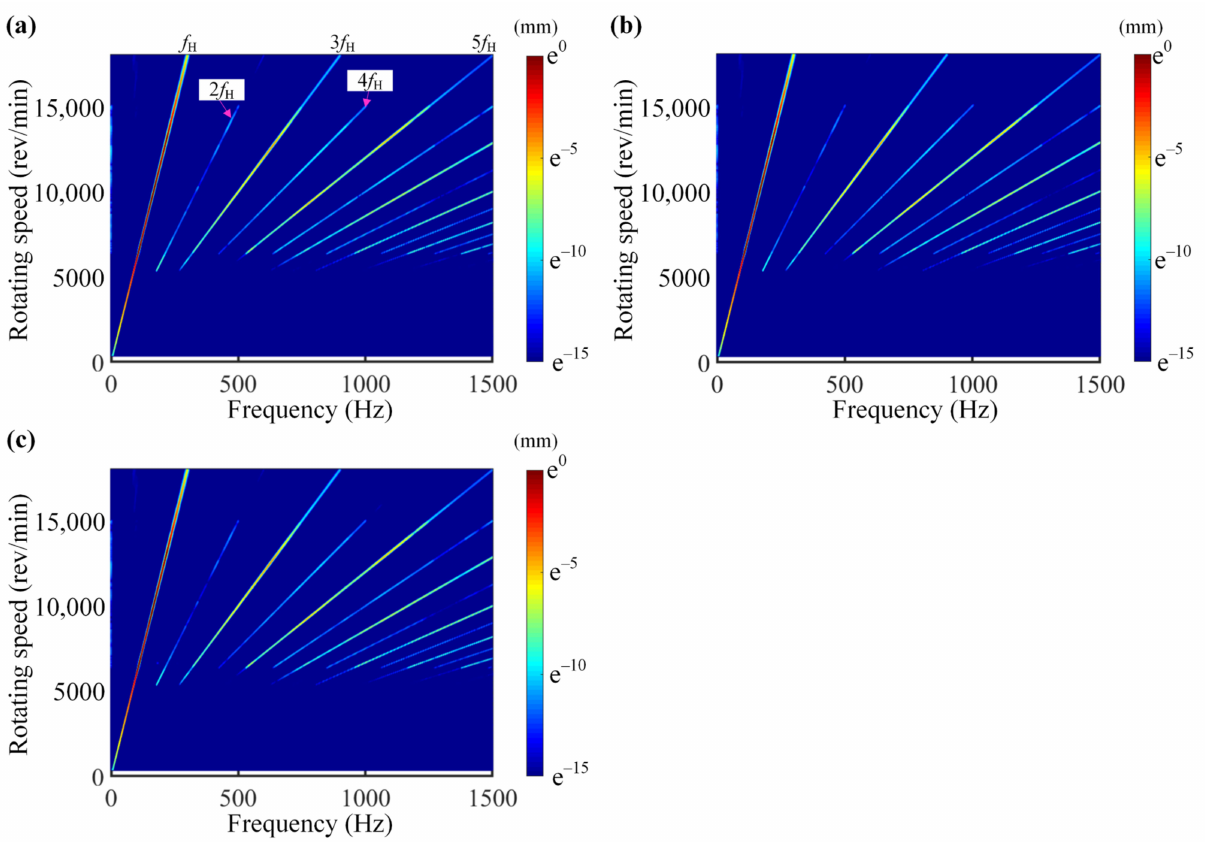
Figure 14. Spectrum cascades of ( a ) prototype and the prediction results from the models ( b ) M1 and ( c ) M2 under HP rotor excitation.